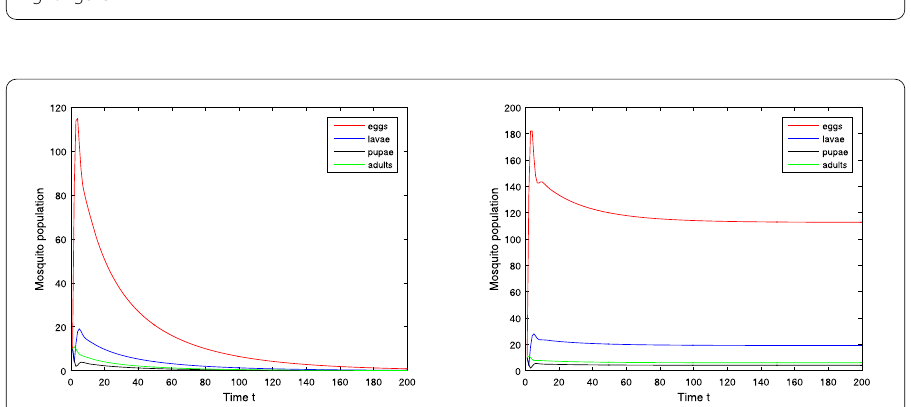
(cid:6) E → ∞ , shown in the left figure. 0 as t